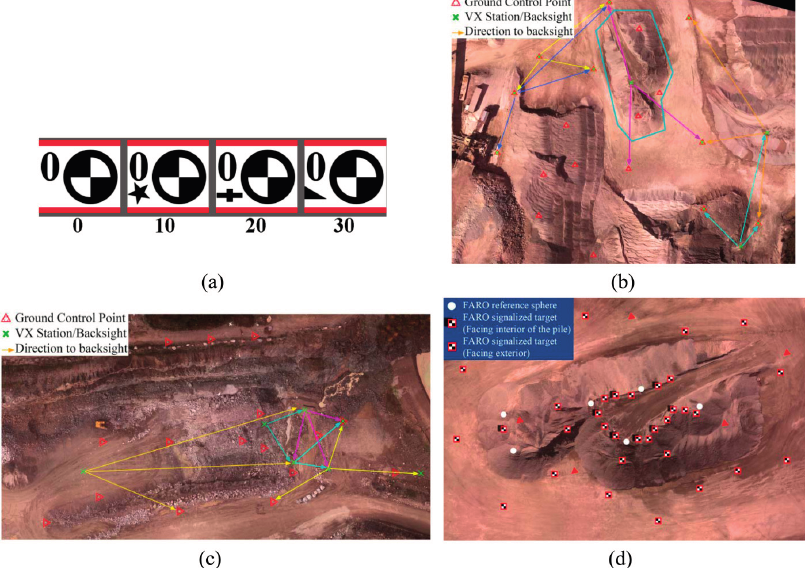
Figure 7. Surveying plans ( a ) Markers for GCPs; ( b ) Configuration of GCPs and laser-scanner stations for dataset A; ( c ) Configuration of GCPs and laser-scanner stations for dataset C; ( d ) Configuration of targets for FARO scanner over one pile.